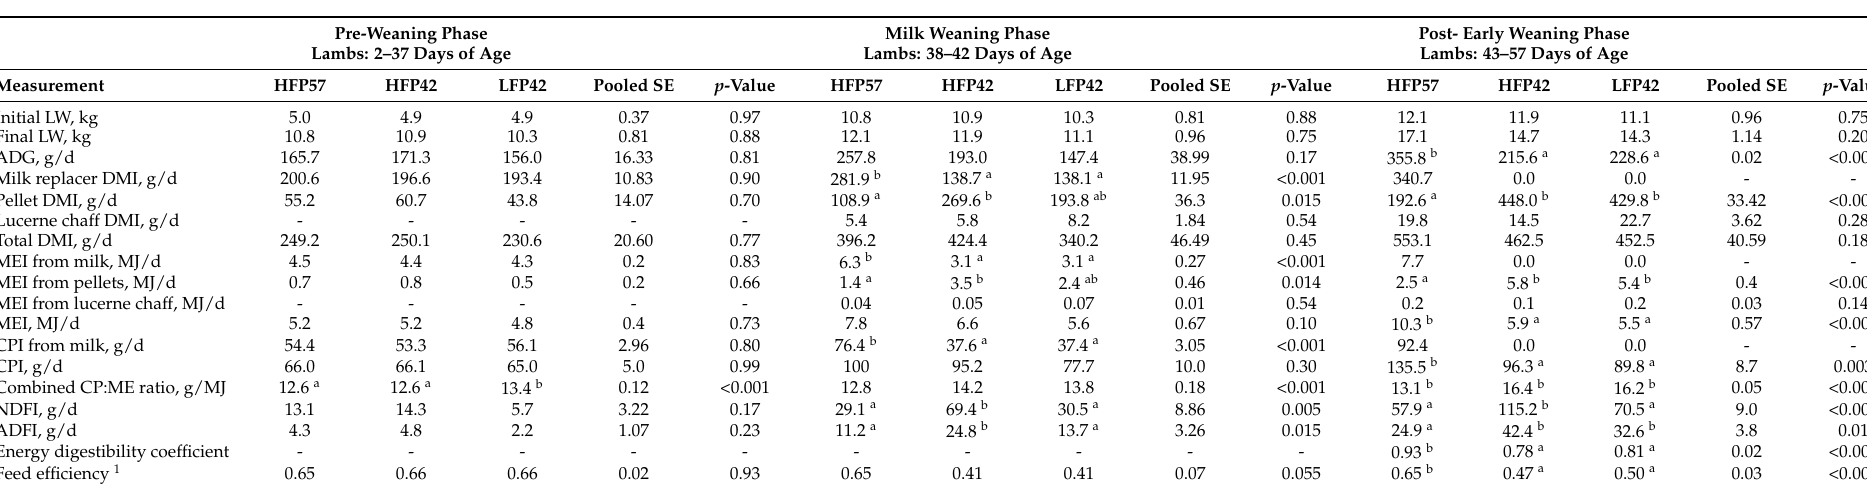
Table 3. Intake and growth performance during different phases (2–37, 38–42 and 43–57 days of age) of artificially reared lambs using three different rearing regimens: HFP57, commercial milk replacer, high fibre concentrate pellets and milk feeding to 57 days of age; HFP42, commercial milk replacer, high fibre concentrate pellets and early weaning at 42 days of age; LFP42, high protein milk replacer from 2–16 days of age followed by commercial milk replacer, low fibre concentrate pellets and early weaning at 42 days of